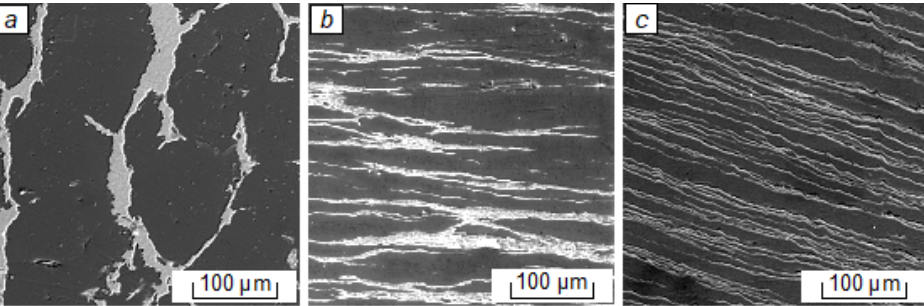
Figure 2. SEM (SE) images of the structure of the Al-30Sn composite in the flow plane of the sample after sintering ( a ) and subsequent two ( b ) and four ( c ) ECAP with route A